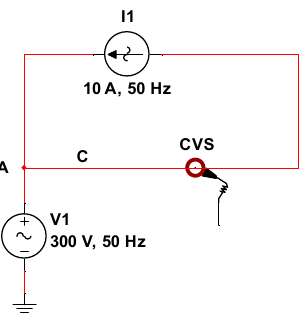
Figure 10. Virtual load connection for the characterization of the contactless voltage sensor (CVS).